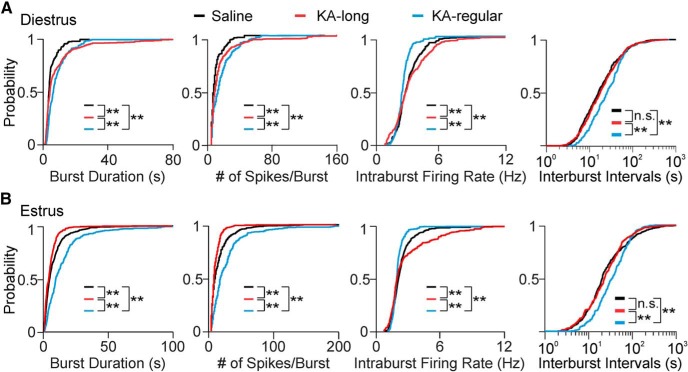
Bursting GnRH neurons from KA-injected female mice show changed burst properties. A, Cumulative probability distributions for burst properties in cells displaying bursting patterns from control (black traces), KA-long (red traces), and KA-regular (blue traces) mice recorded on diestrus. Cumulative distributions were constructed using 100 randomly selected bursts per cell. B, Cumulative probability distributions for burst properties recorded on estrus; **p < 0.01 for comparisons between saline, KA-long, or KA-regular groups by pairwise Kolmogorov–Smirnov tests. n.s., not significant. The interburst intervals are presented on logarithmic scales for better visualization of the major portion (1–99%) of the distributions.